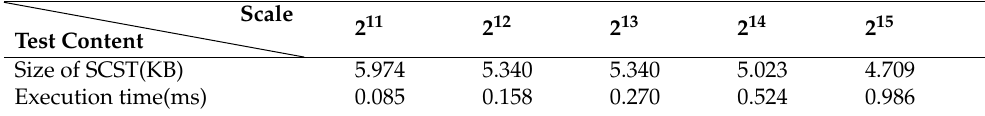
Table 4. Add/Delete An Edge Server.